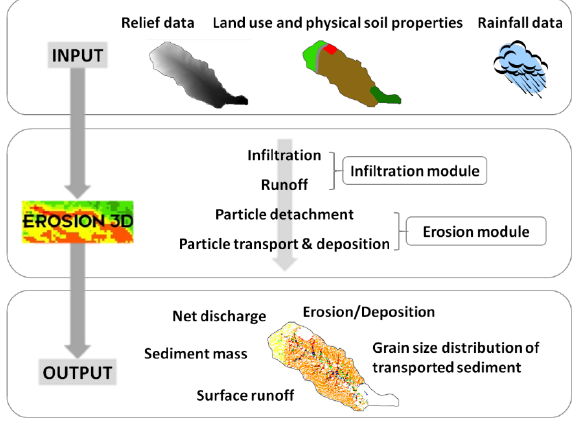
Figure 2. Flow chart of EROSION 3D program sequences (changed after [42]).